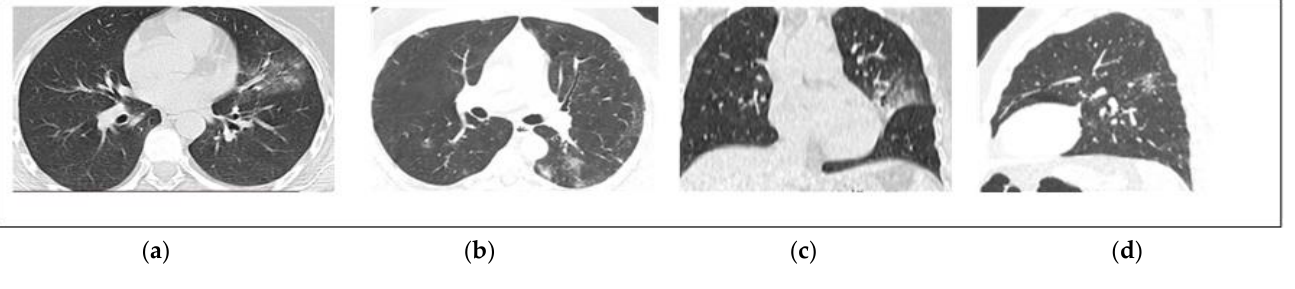
Figure 2. Non-contrast chest CT axial ( a , b ), coronal ( c ), and sagittal ( d ) reconstructed images for a 38-year-old male with mild COVID-19 infection. CT images show small ground-glass opacities in both lobes with left upper lobe consolidation. The TSS is 4.